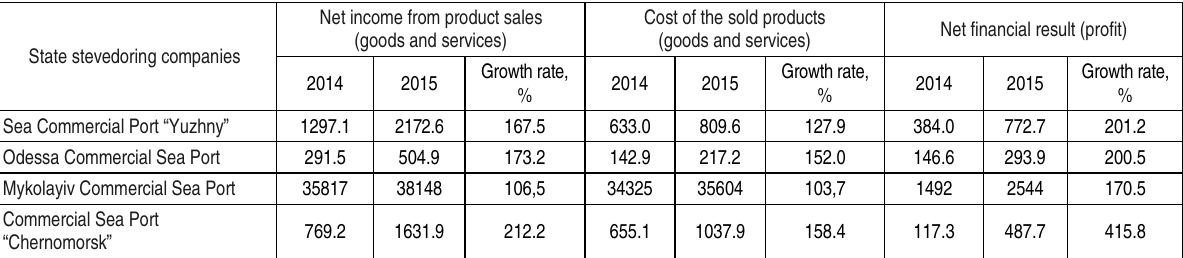
Table 2. Financial indicators of public stevedoring